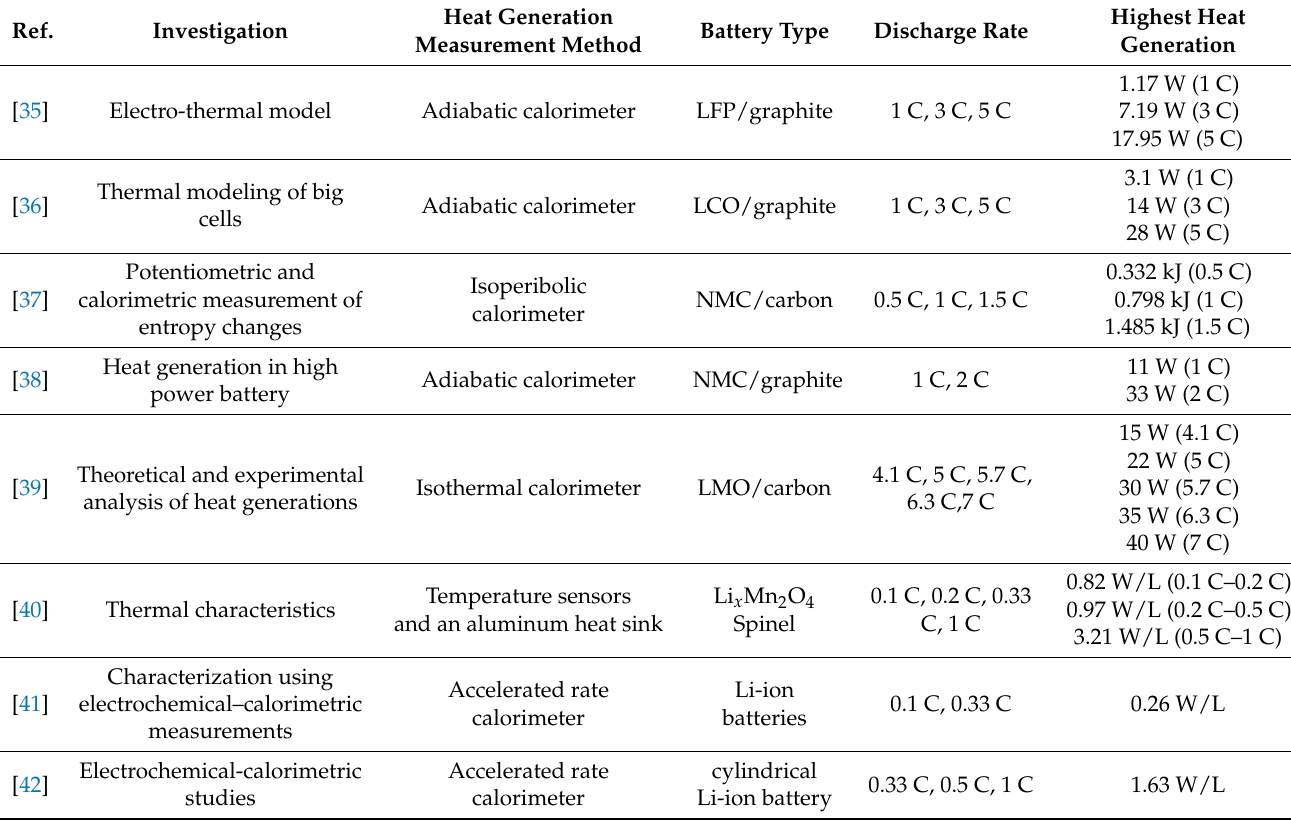
Table 1. Literature overview on heat generation measurements of lithium-ion batteries.